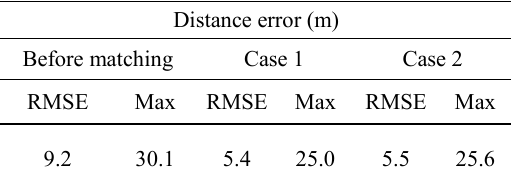
Table 2. Distance errors between 505 ICESat points and the surface points of DEM